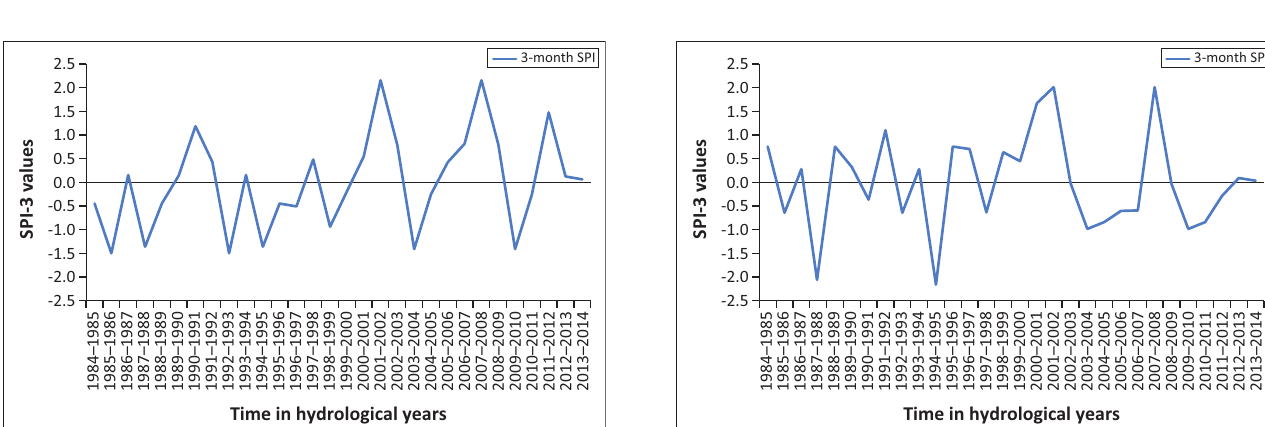
FIGURE 2: Three-month standardised precipitation index: January–March, 1984–2014.